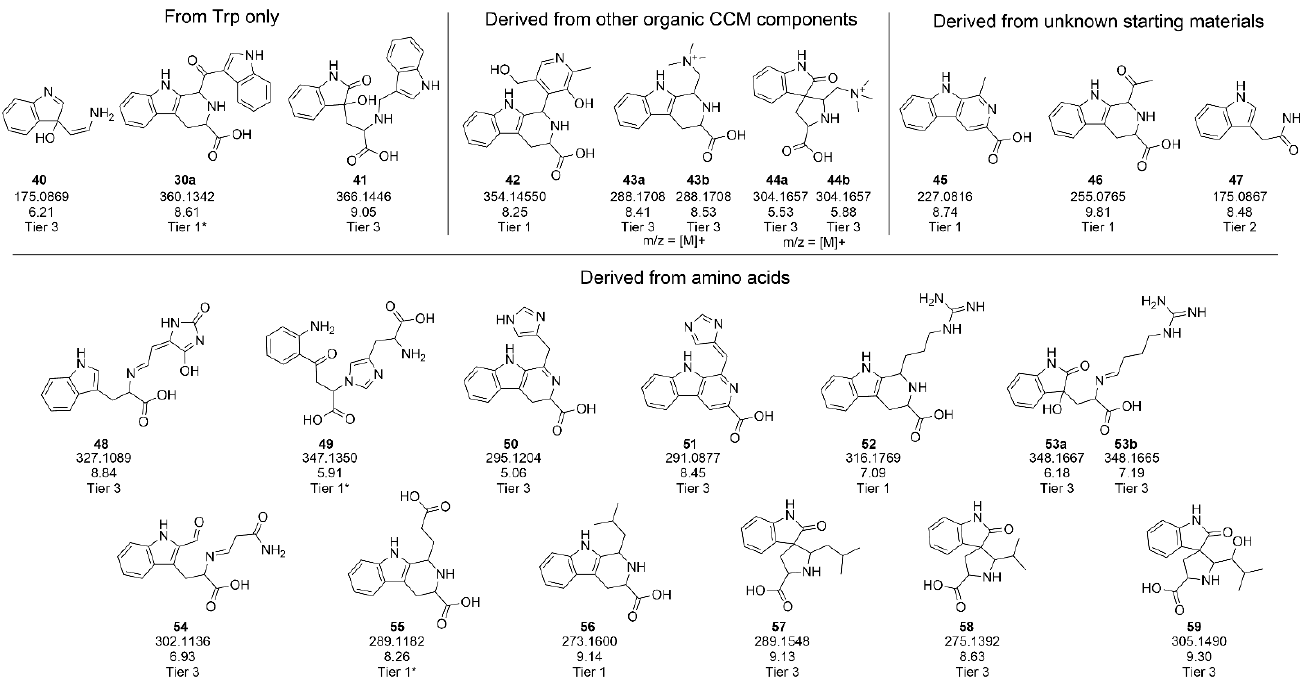
Figure 5. Structures for novel Trp degradants detected in feed studies (those features detected in both water and feed studies are shown in Figure 4 with their feature data marked in blue). Structures are provided for tier 1–3 features that were significantly modulated in the Trp-containing feed compared to the Trp-depleted feed. All m/z represent the parent peaks detected as [M + H] + ions, unless indicated otherwise.